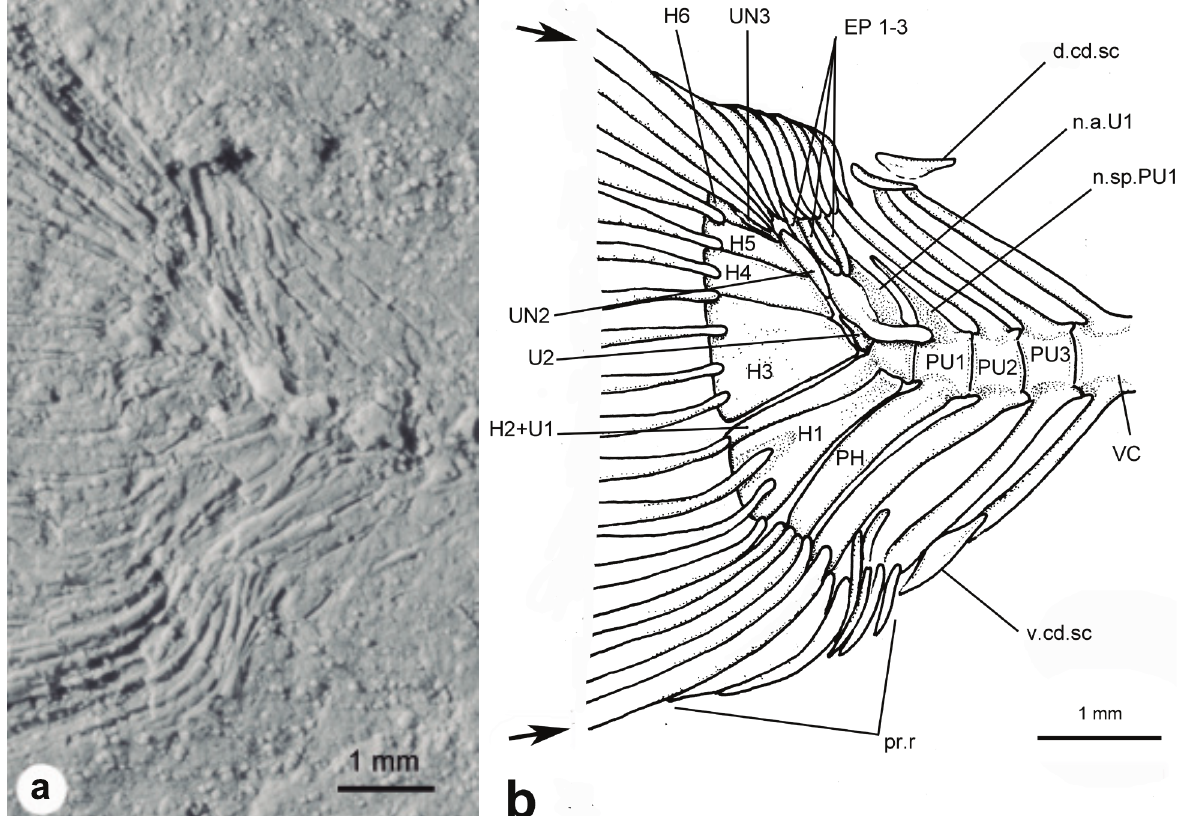
Figure 10 . † Scutatuspinosus itapagipensis Santos and Corrêa 1985: ( a ) caudal skeleton of DGM 1253-P; ( b ) restoration of caudal skeleton based on DGM 1253-P. Arrows indicate leading upper and lower principal caudal